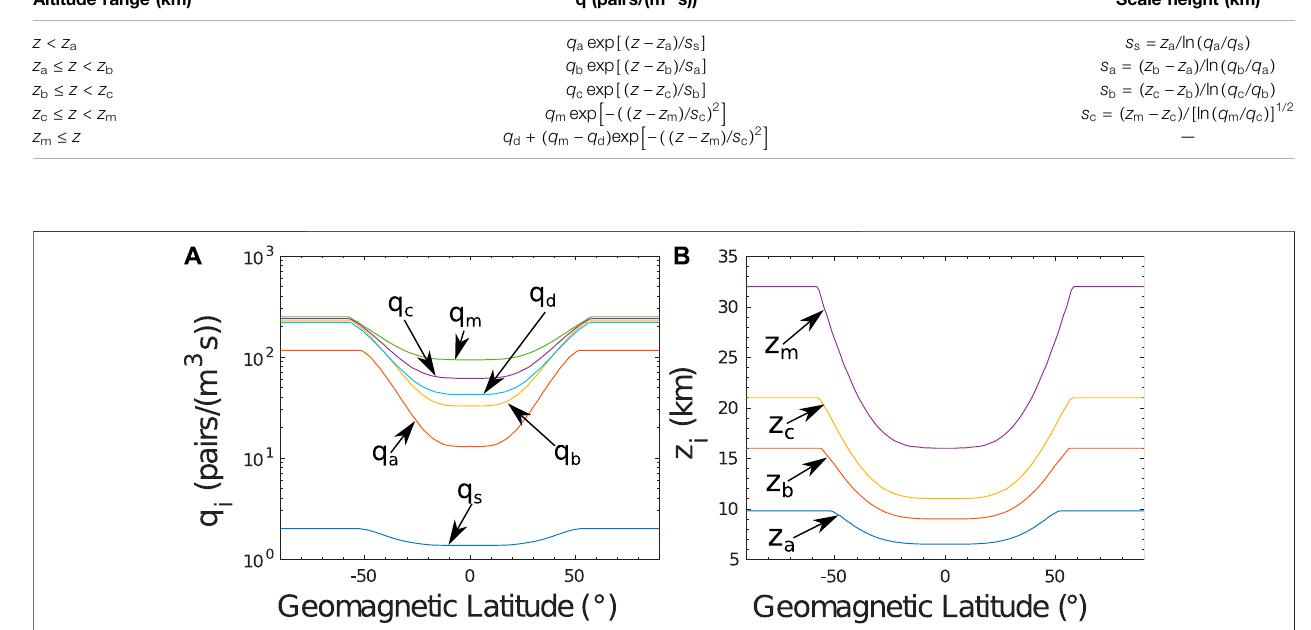
TABLE 2 | Interpolation formulas and their scale heights for ionization rates, q . Altitude range (km)